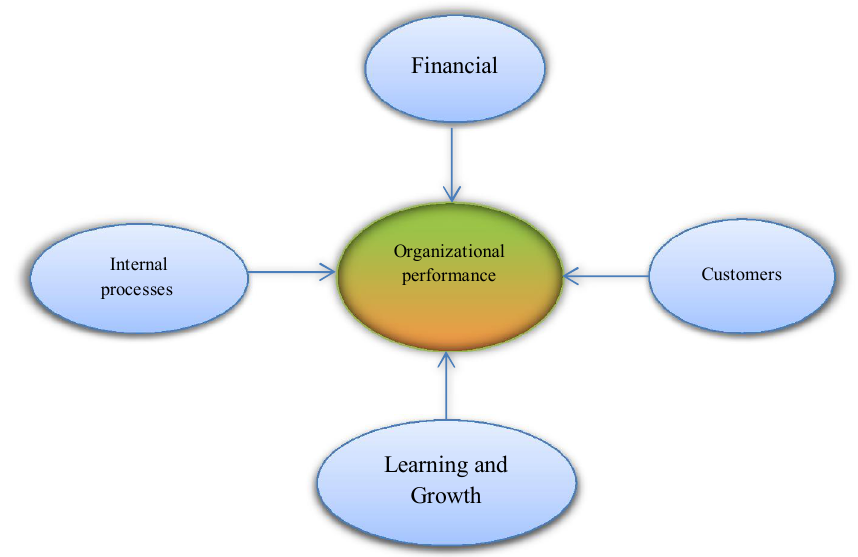
Fig. 1. The Four Perspectives in